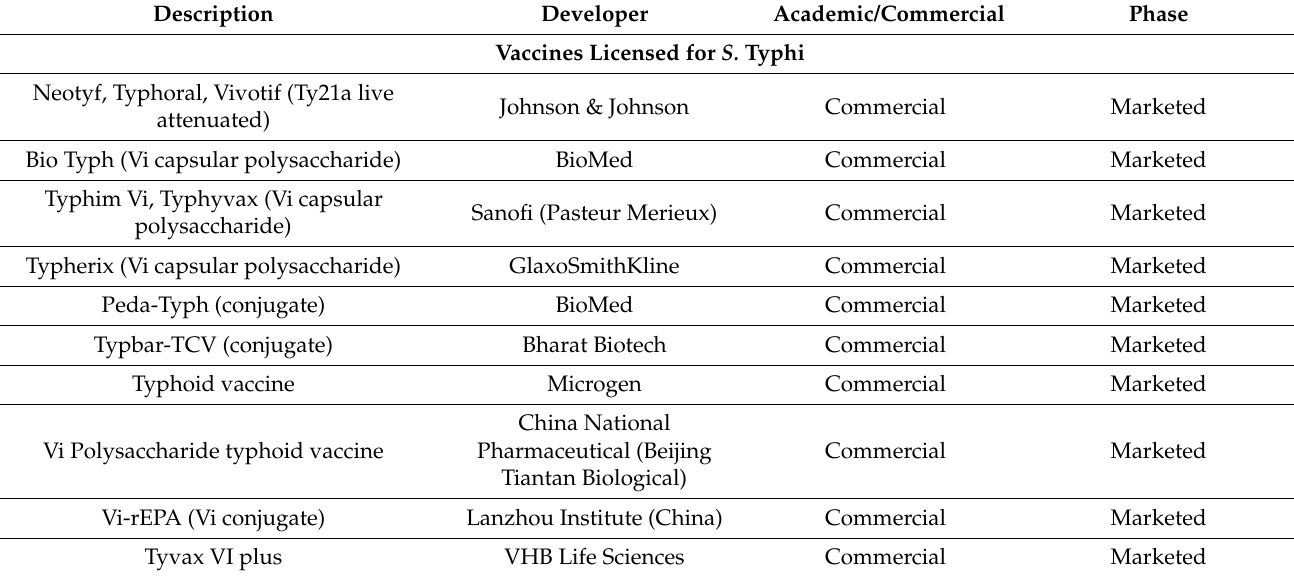
Table 2. Human vaccines currently licensed and vaccine candidates being developed for S . Typhi, S . Paratyphi A, and non-typhoidal Salmonella a